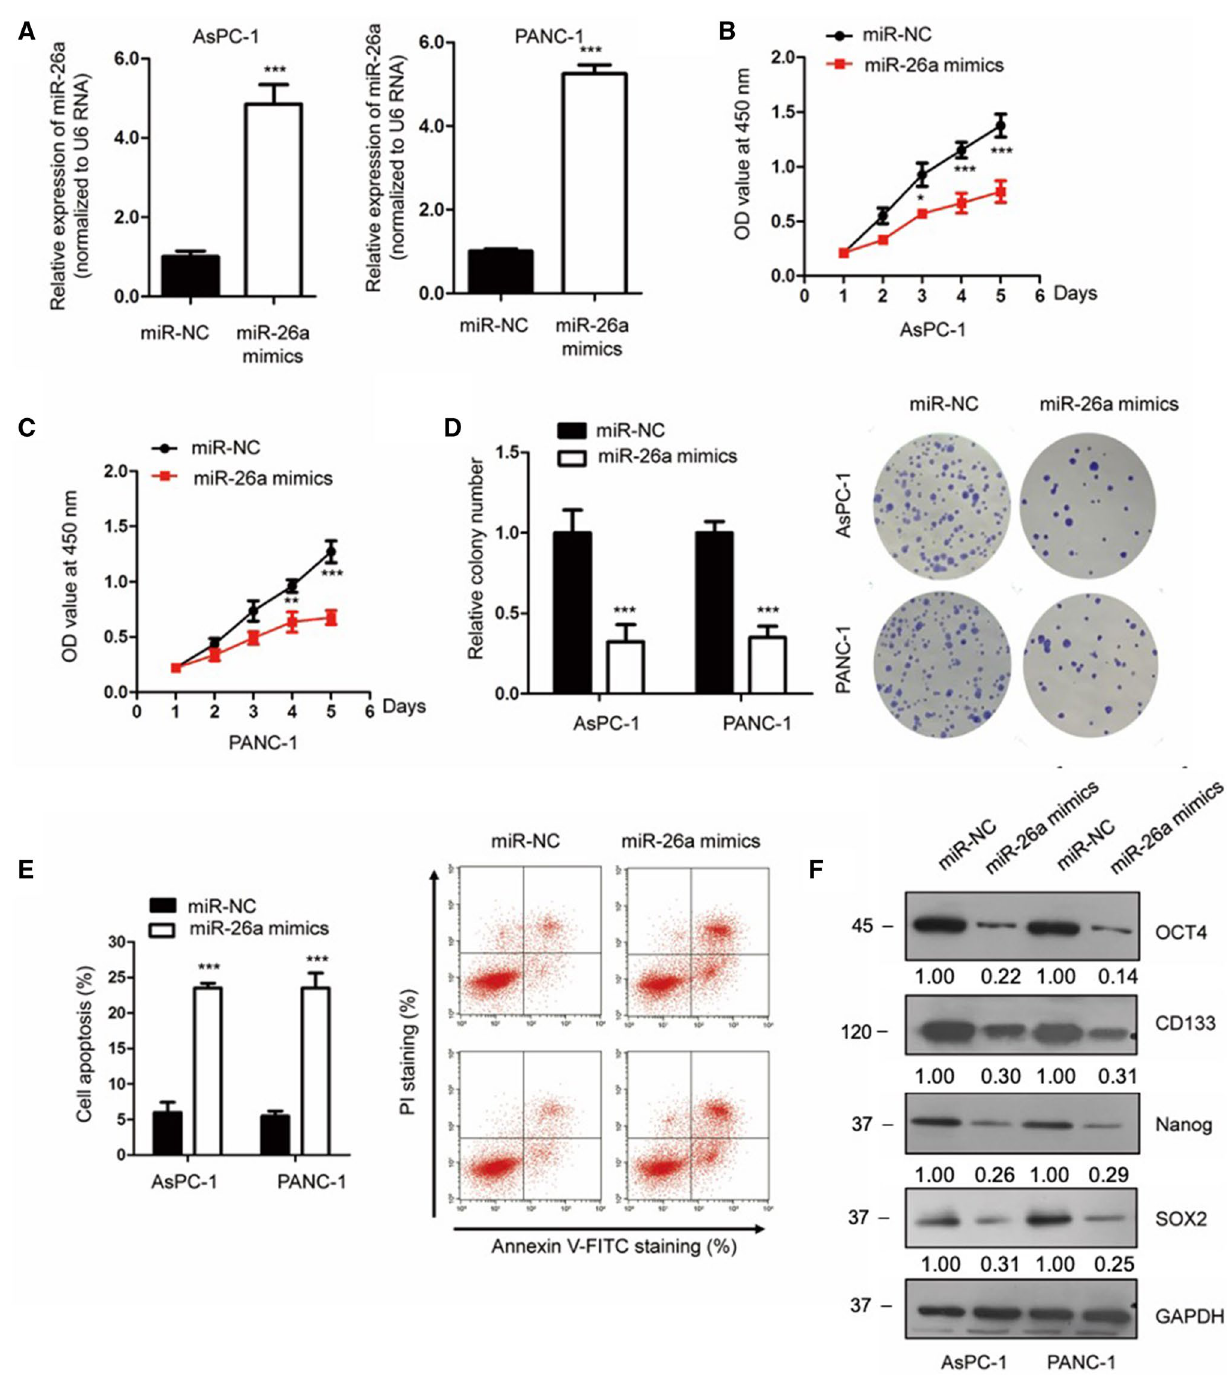
Fig. 2 miR-26a suppressed the proliferative ability of PCa cells. A miR-26a expression of AsPC-1 and PANC-1 cells after miR-26a transfection. B , C The proliferation of PCa cells with overexpression of miR-26a was significantly inhibited. D miR-26a transfection decreased the number of PCa cells. E miR-26a enhanced apoptosis of both AsPC-1 and PANC-1 cells. F The expression levels of the stemness markers in PCa cells were examined after transfection of miR-26a. * P < 0.05; ** P < 0.01; *** P <